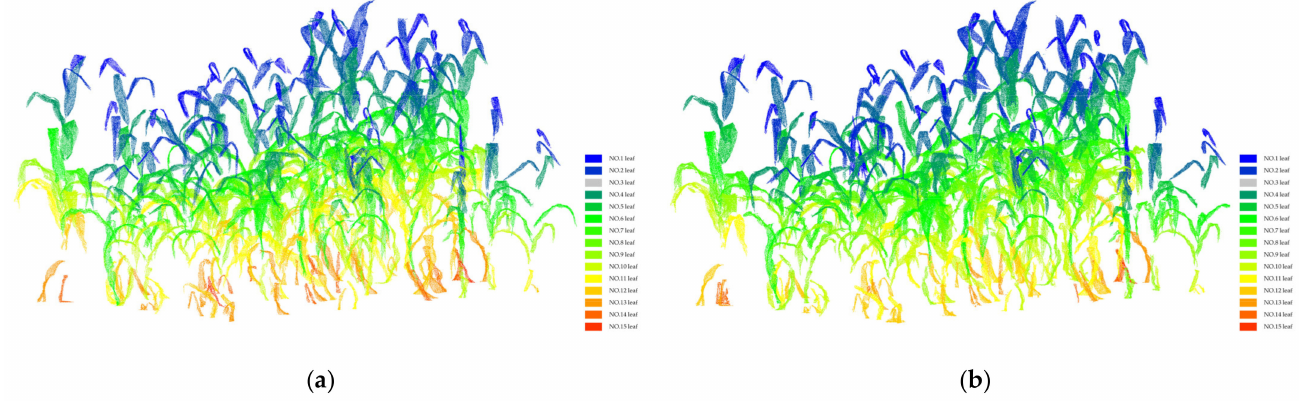
Figure 13. Stratification visualization of maize leaves. Sort by leaf p 1 point elevation value in descending order and render the colors one by one (Figure 7). ( a ) Standard value; ( b ) Predictive